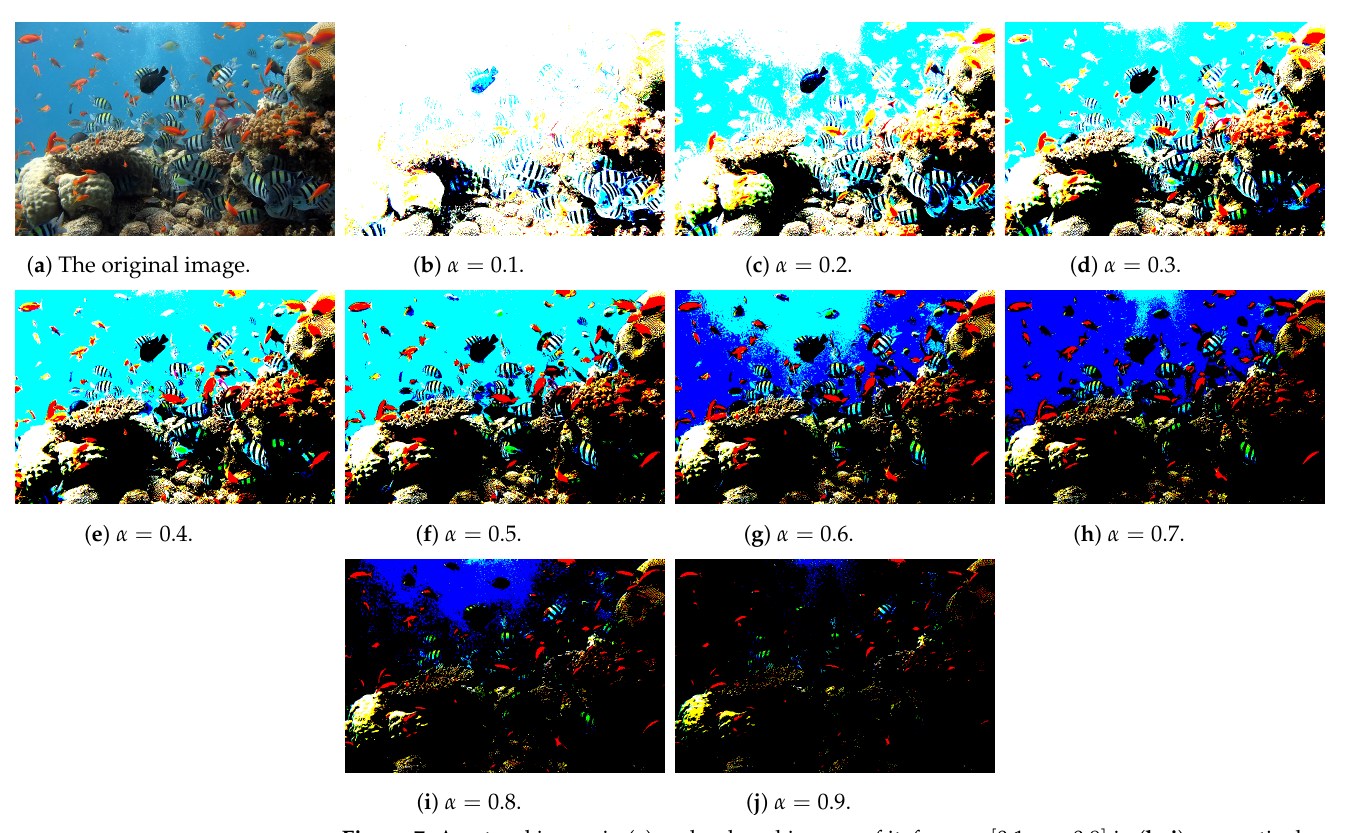
Figure 7. A natural image in ( a ) and reduced images of it, for α = [ 0.1, . . . ,0.9 ] in ( b – j ),